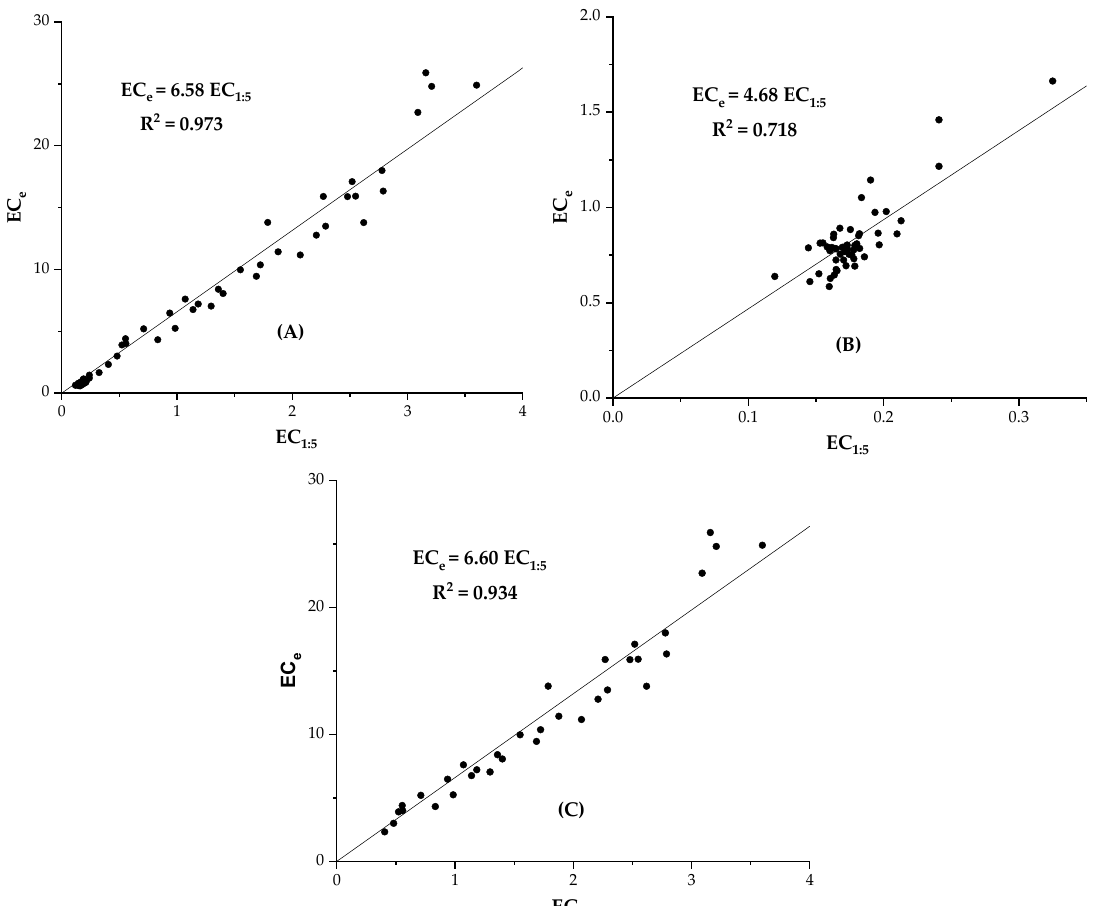
Figure 1. Relationship between EC e and EC 1:5 for NRCS extraction method. A: all soil samples, B: soil